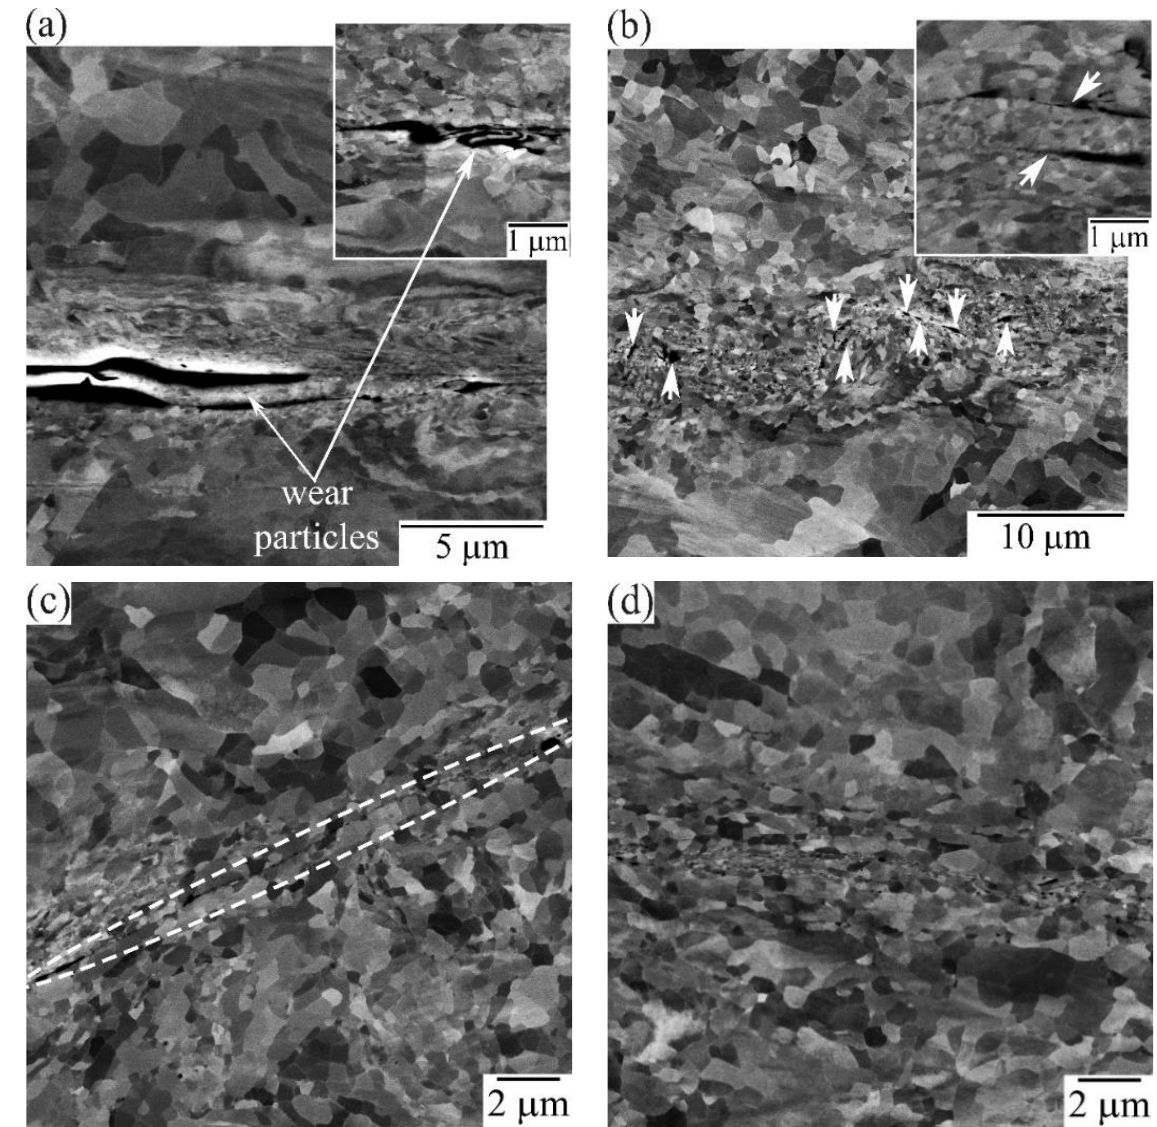
Figure 4. Typical backscattered electron images of the joint zone: ( a ) gaps with pilling wear particles; ( b ) partially bonded regions with single and parallel rows of small discrete voids (shown by arrows); ( c ) wave-like profile of an interface (outlined) and refined microstructure around it; and ( d ) well-bonded region.